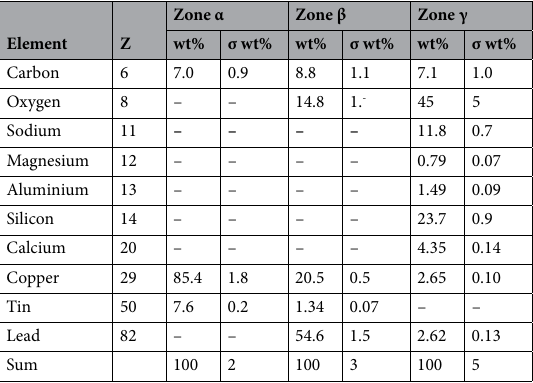
Table 3. Elemental composition of the sampling points of the bulk of inclusion #2 showed in Fig. 6. Data collected with FESEM-EDS.